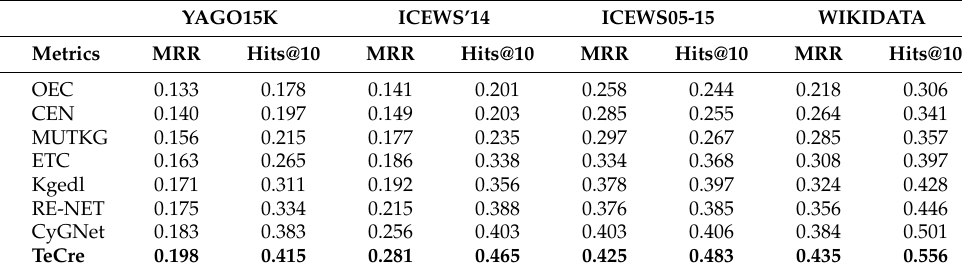
Table 3. Link prediction results on the four datasets (the best results are shown in bold). YAGO15K ICEWS’14 ICEWS05-15 WIKIDATA Metrics MRR Hits@10 MRR Hits@10 MRR Hits@10